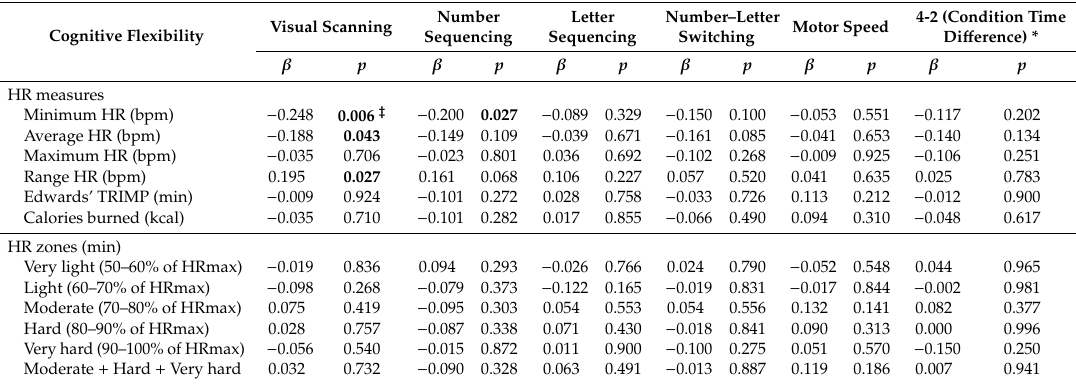
Table 4. Associations of HR measures with cognitive flexibility subdomains ( n = 130).